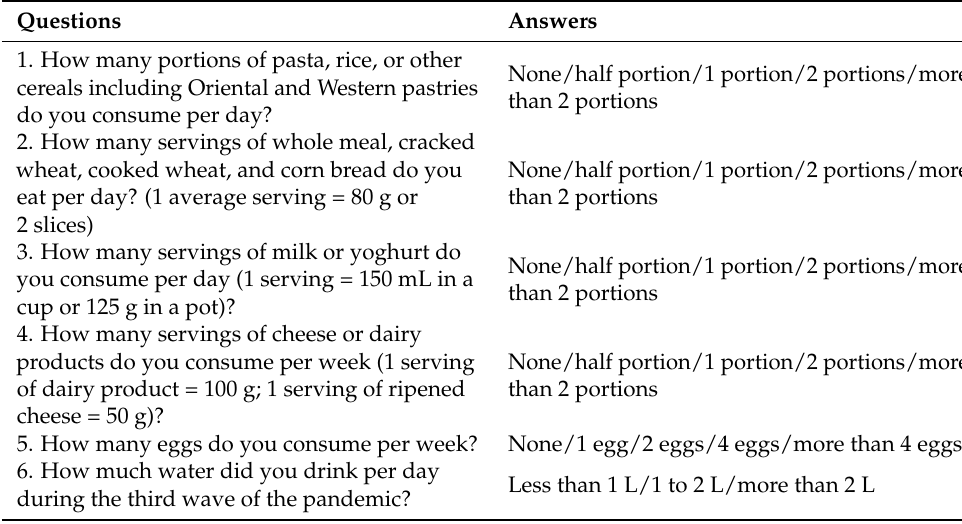
Table A4. Eating habits related to Mediterranean diet.